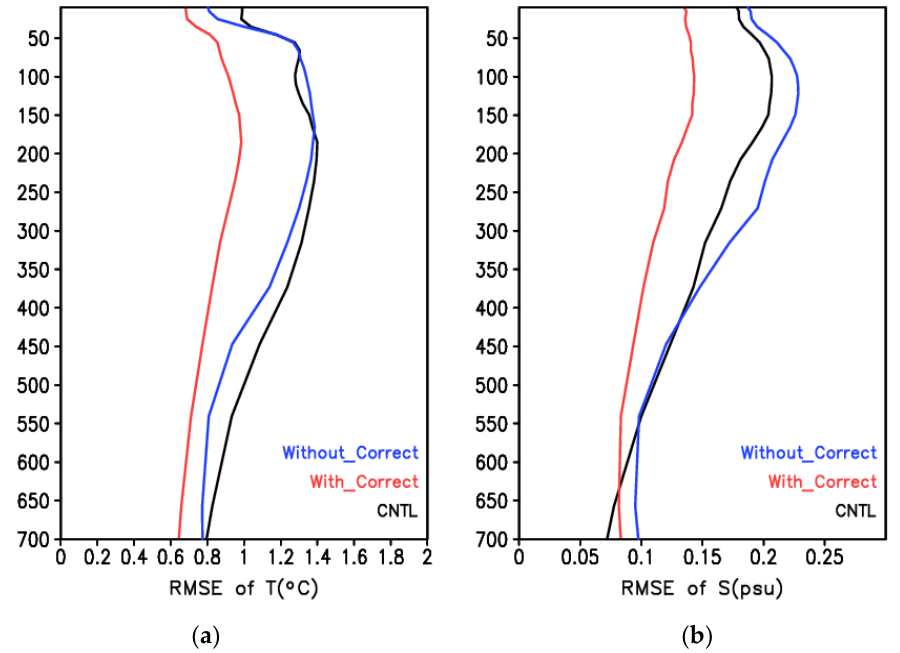
Figure 4. Vertical distribution of the RMSEs of ( a ) temperature and ( b ) salinity in the southern Indian and Pacific oceans over the period 1993–2005 for different experiments.